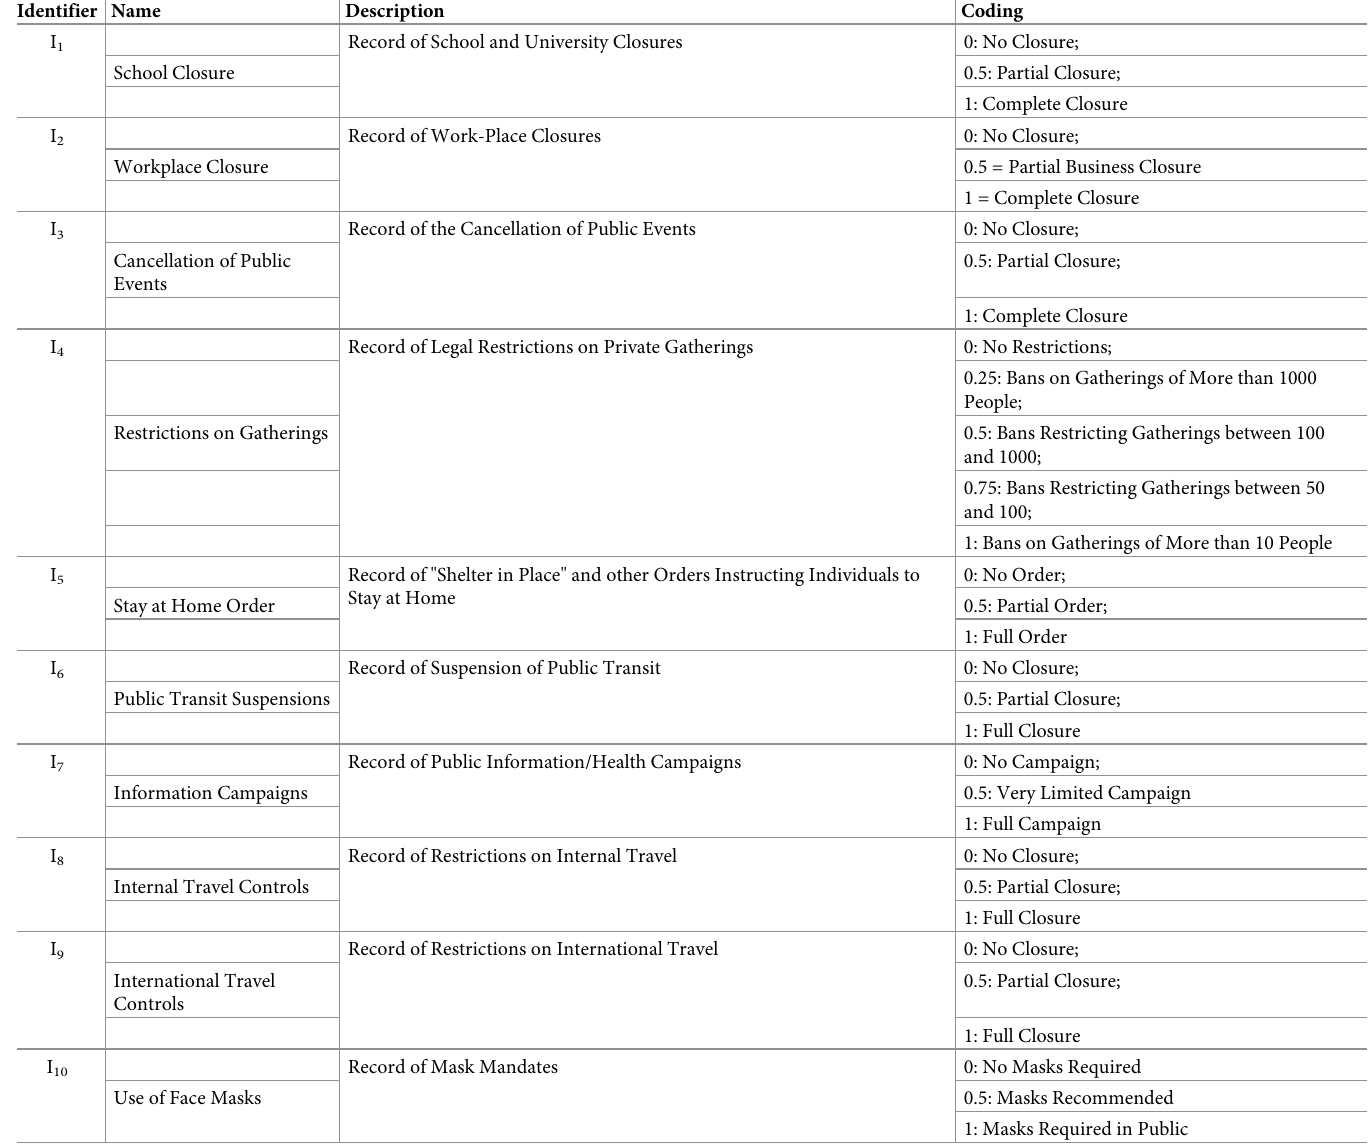
Table 1 describes the 10 variables and the possible values in their measurement. We assign several discrete levels to the variables to achieve greater granularity in the analysis. These val- ues were determined through deliberations with the research team and advice from external scientists such as the OxCGRT COVID policy tracking team at Oxford University. The vari- ables "school closings", "work from home", "cancellation of public events", "suspension of pub- lic transport and / or closure of public transport systems" are categorical and take values of 0 when they have not been implemented, 0.5 when implementation is partial and 1 when it is total. The variable "development of information campaigns" is evaluated through the relative presence or absence of an informational strategy about the virus, the disease, its consequences and containment measures. Values of 0 are assigned if there were no campaigns; 0.5 represents Table 1. Public policy indicators to contain